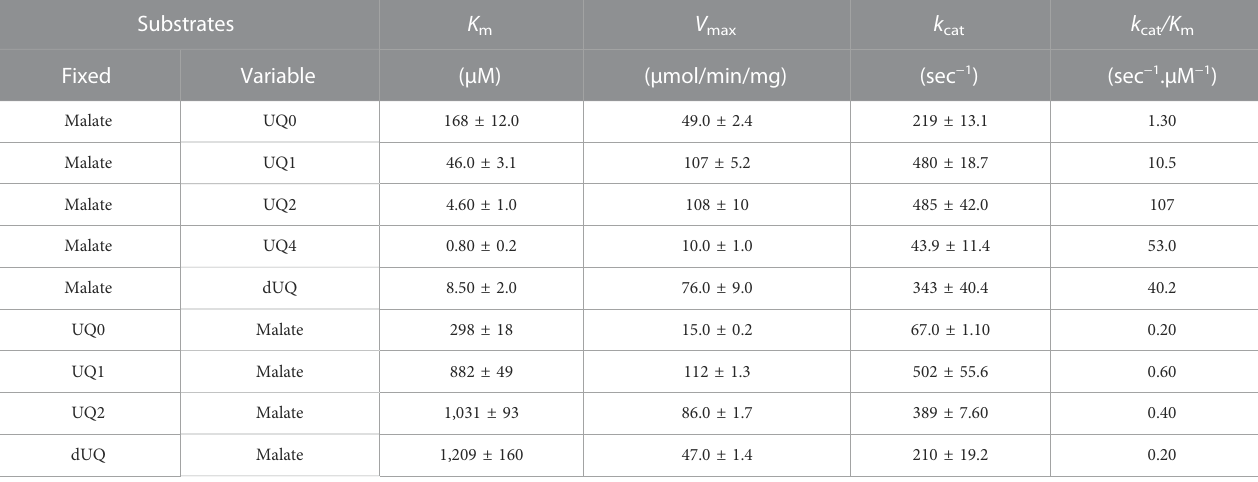
TABLE 2 Summary of apparent steady-state kinetic parameters of CjMQO.